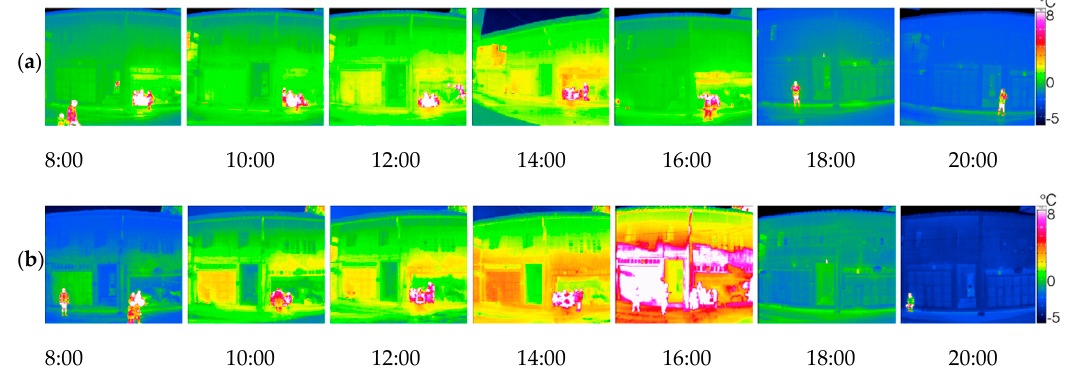
Figure 19. Thermographs of the timber façade taken in 2014 on: ( a ) February 16th (a cloudy day) and ( b ) 20th (a sunny day).